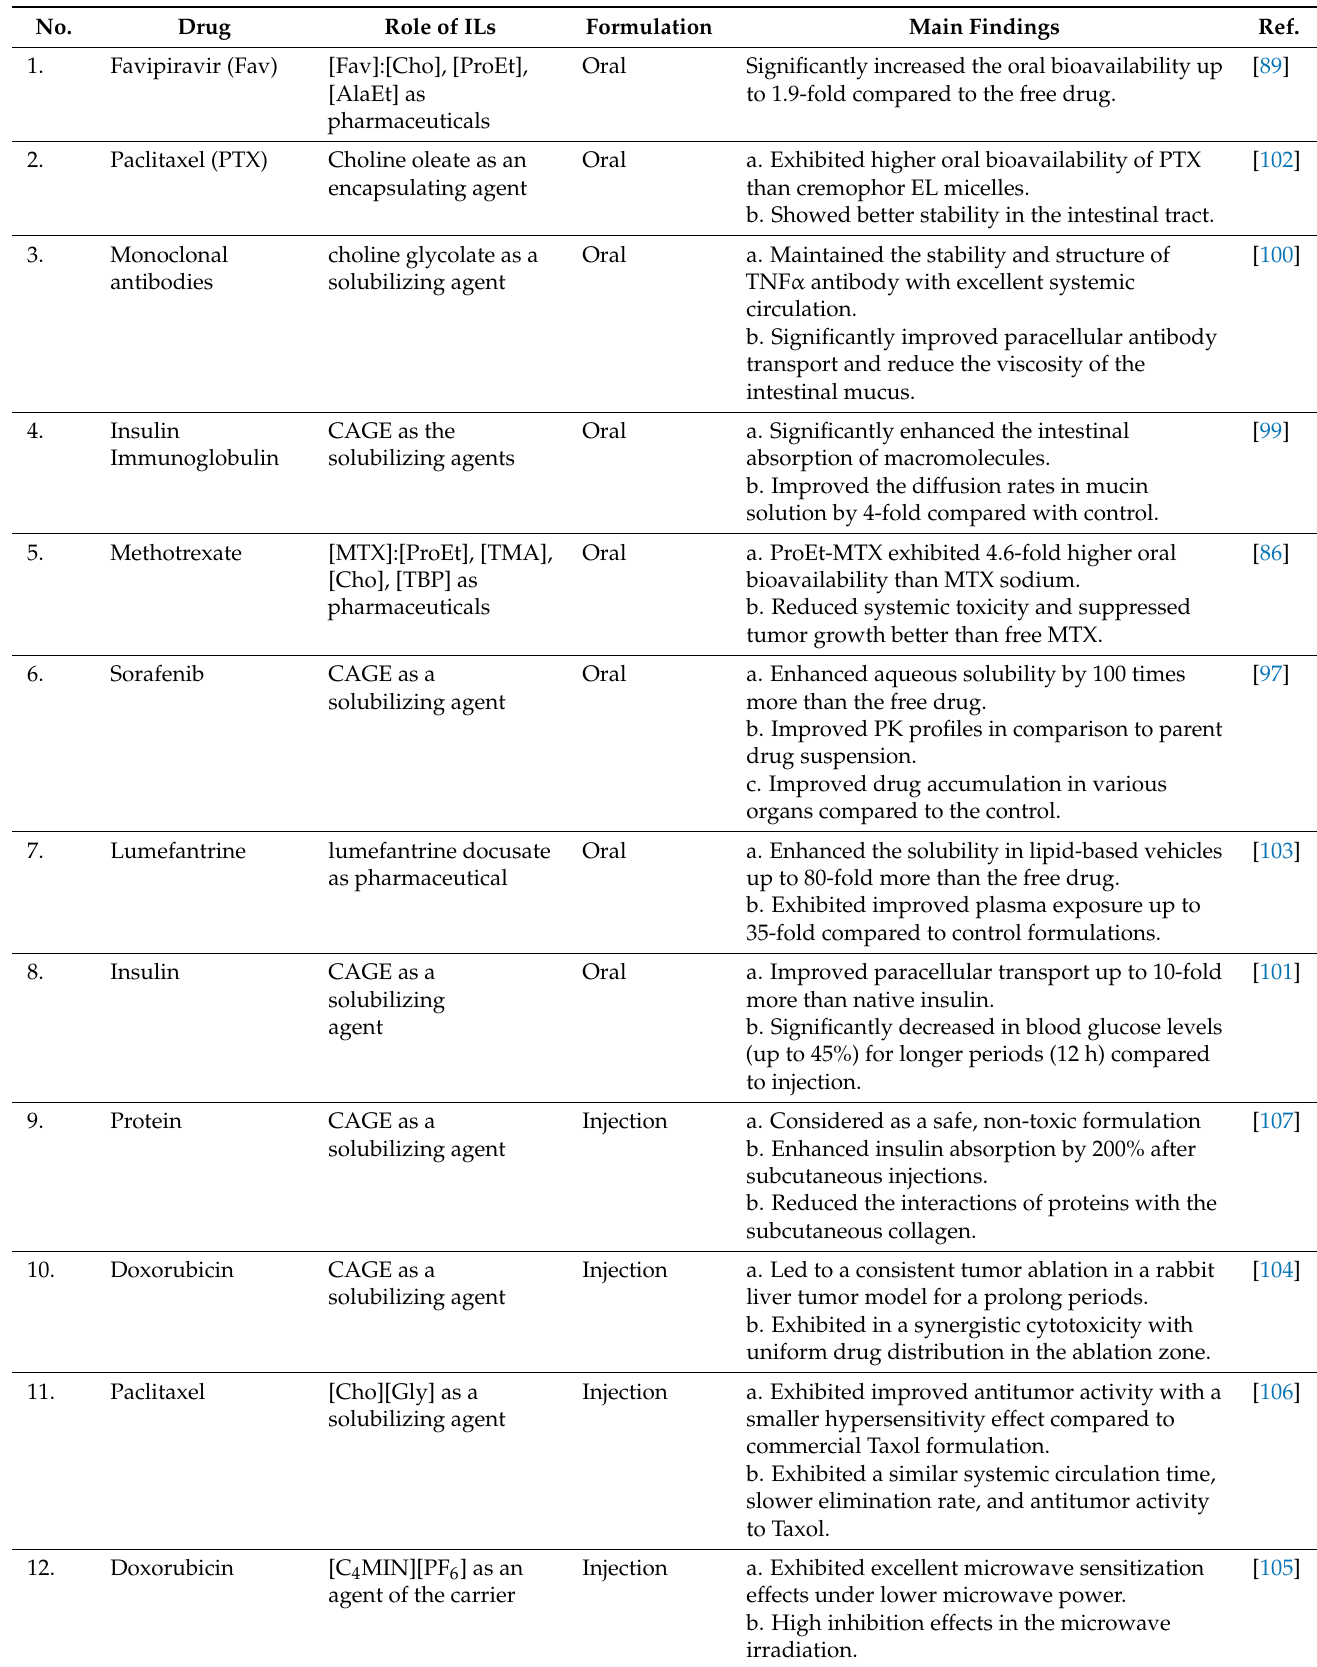
Table 2. Bio-ILs in various drug formulations and delivery